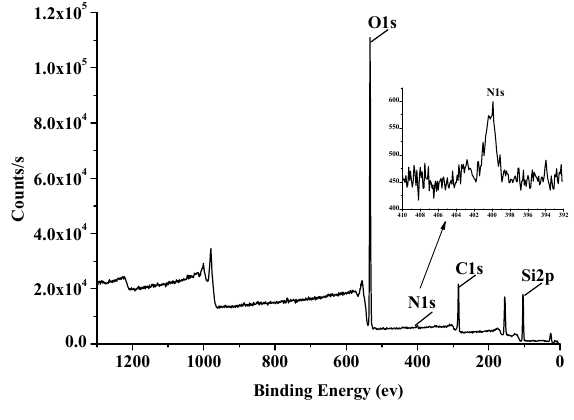
Figure 2. The XPS spectrum of CPM2. Table 1. Elemental analysis data for two core-shell CPMs.